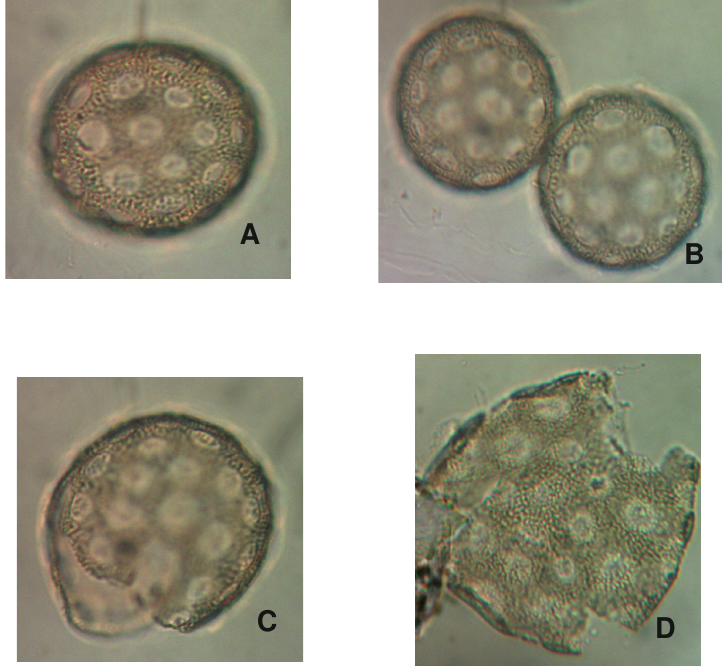
Fig. 6. Pollen grains of T . triangulare white petals (×400) A. Acolpate, B. Dyad pollens, C. Monocolpate, D. Tricolpate